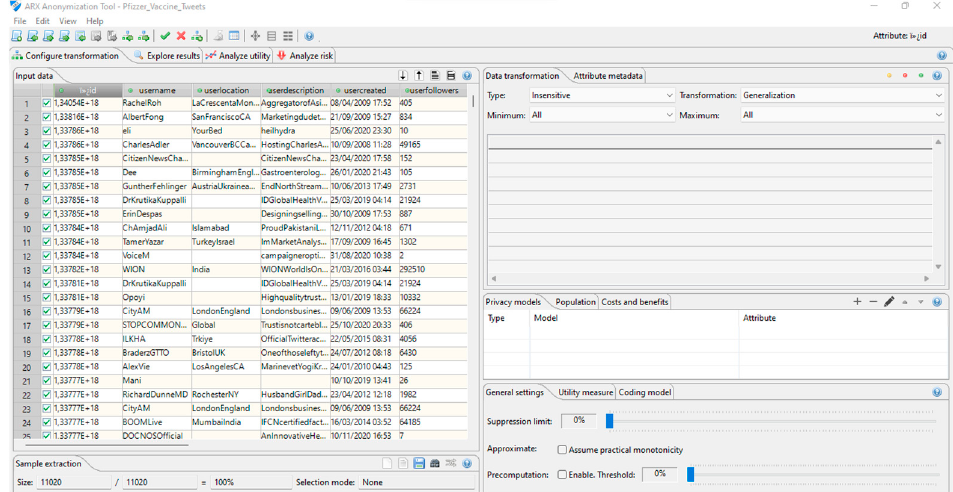
Figure 4. Dataset uploaded in ARX Data Anonymization.